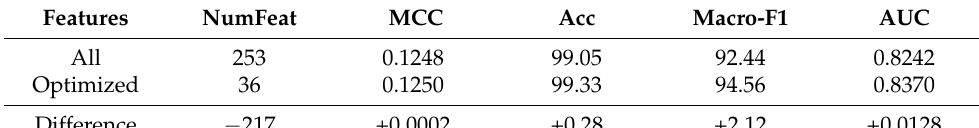
Table 3. Classification test result.